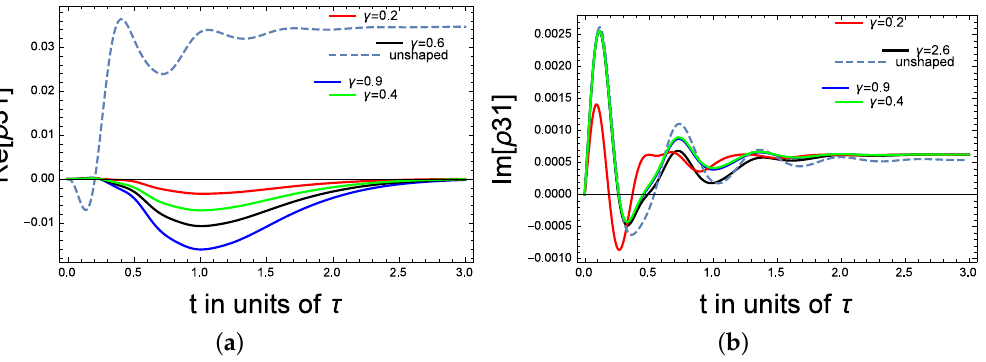
Figure 6. ( a ) The coherence for tunable amplitude of the microwave field: the real part. ( b ) The coherence for tunable amplitude of the microwave field: the imaginary